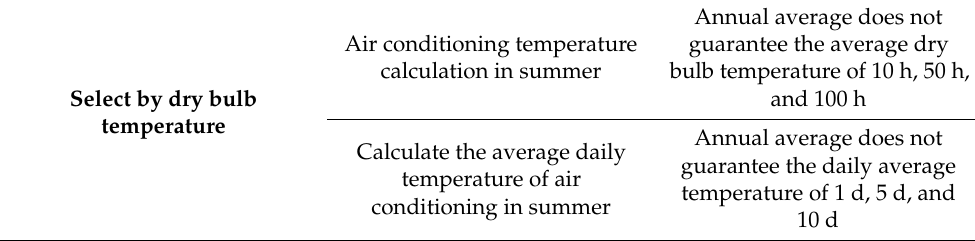
Figure 10. Predicted value ˆ β tem Comparison of β syn , β wet , and β ws in Beijing ( a ) and Shanghai ( b ). According to the comparison results, compared with β in the specification, the amplitude of β obtained by the K-means method is larger in the Beijing area. In the data for the Shanghai group, except for the data at 9:00 am, β obtained by the K-means method is higher than β in the specification. According to the prediction results of LSTM, the variation trend and amplitude of β predicted in the Beijing group data were roughly the same as those in the specification, and the peak appeared 2 h earlier, and the data from 7:00 to 15:00 were higher than those in the specification, while the predicted value of LSTM in the Shanghai group data was higher than that of K-means.